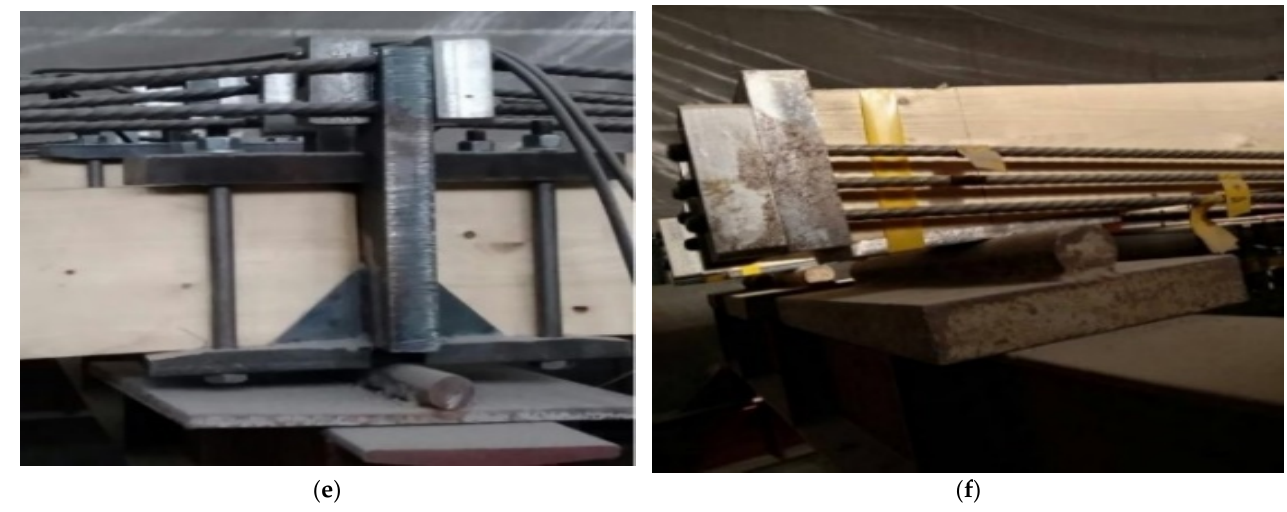
Figure 1. Diagrams of prestressed glulam continuous beam: ( a ) steel plate and anchor, ( b ) prestressed control device, ( c ) connection apparatus, ( d ) details of specimen, ( e ) photo of the connection apparatus, and ( f ) photo of the steel plate and anchor.